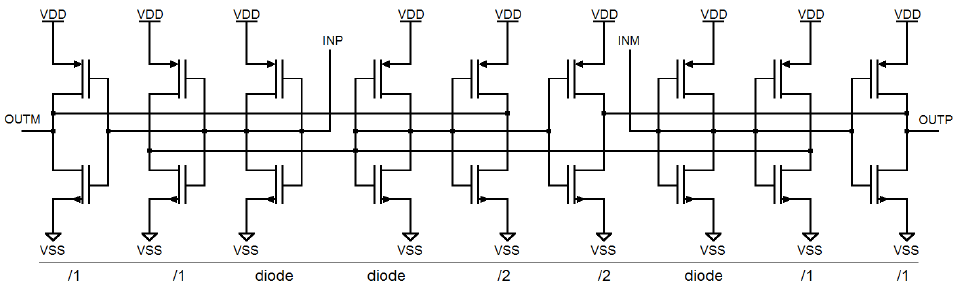
Figure 3. Circuit removing the concurrent component